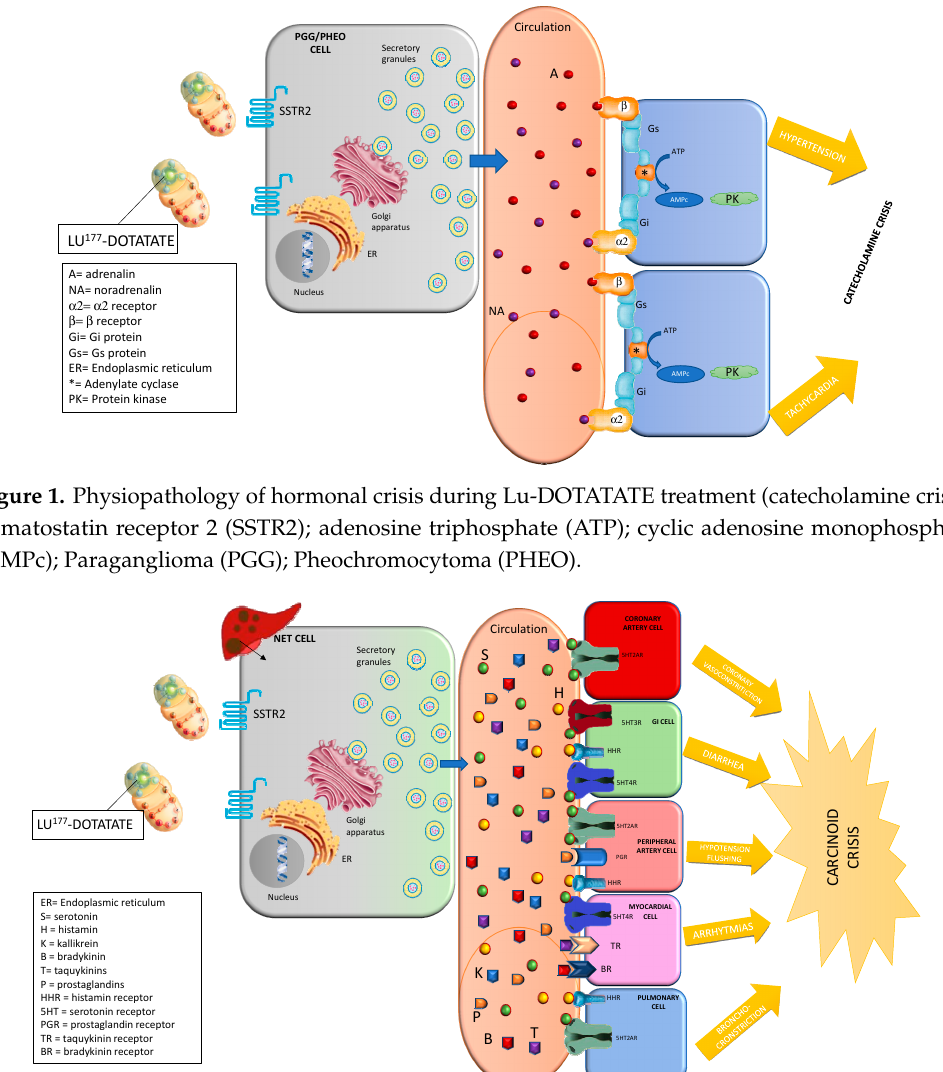
Figure 2. Physiopathology of hormonal crisis during Lu-DOTATATE treatment (carcinoid crisis).